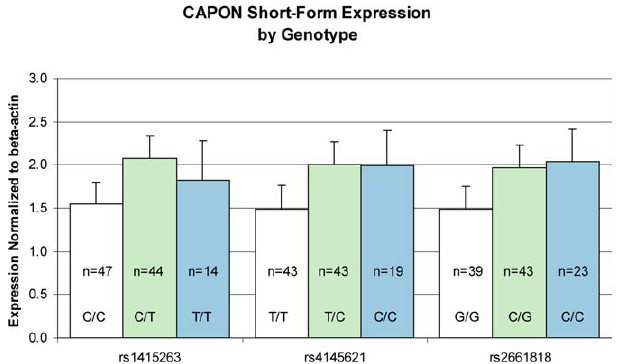
Figure 5. ACTB (Beta-Actin)–Normalized CAPON mRNA Short-Form Expression by Genotype Expression levels are least squares means. Individuals from all three diagnostic classifications are included, grouped only by genotype. Mean values per genotype for each SNP are plotted with 95% confidence intervals. The number of individuals per genotype is indicated within each bar. SNP alleles are given for forward strand sequence. All three SNPs exhibit significantly ( p , 0.05) different levels of CAPON expression by genotype, with a dominant effect. Higher levels of CAPON are seen in individuals with one or two copies of alleles previously identified as associated with schizophrenia (T, rs1415263; C, rs4145621; and C, rs2661818). The mean (95% confidence interval lower bound, upper bound) for the three genotypes for each SNP are as follows. For rs1415263: 1.54 (1.29, 1.80) for CC; 2.07 (1.81, 2.34) for CT; and 1.83 (1.36,